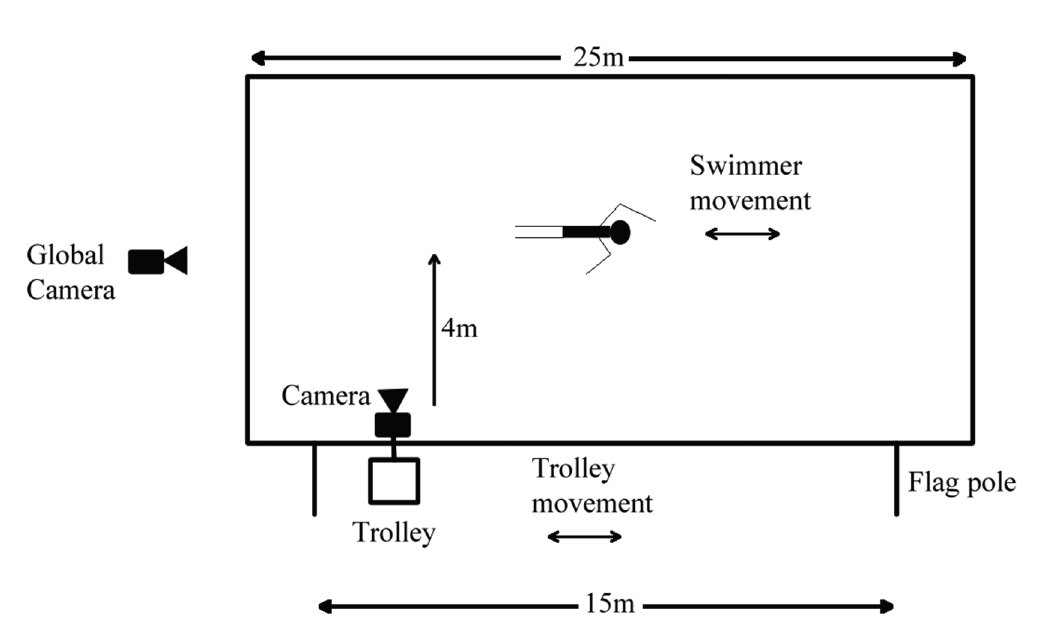
Figure 2. Experimental